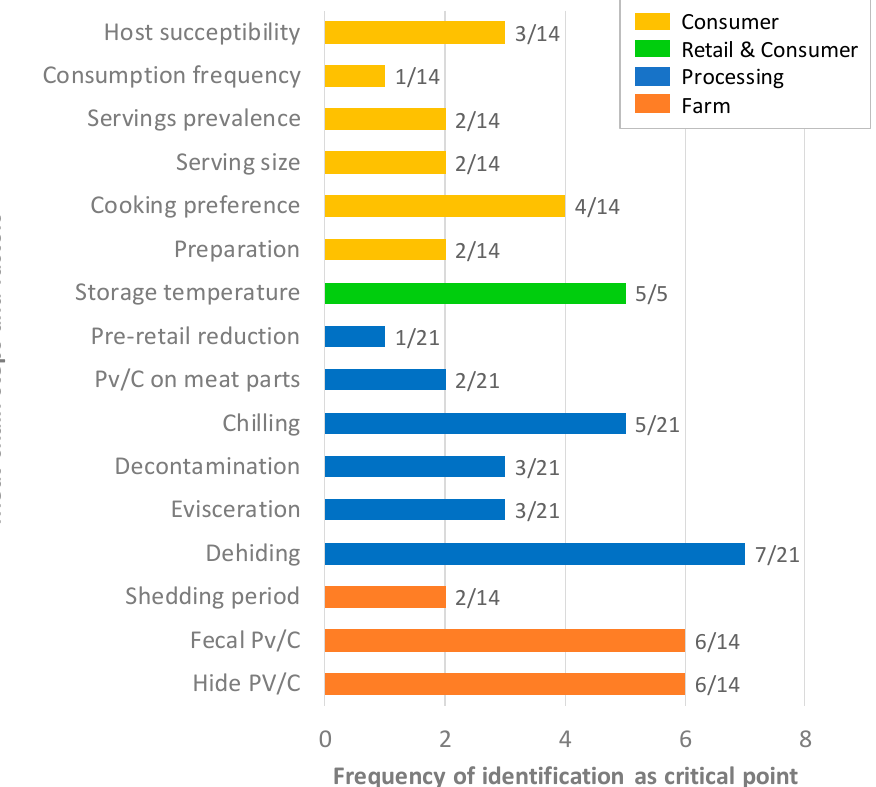
Figure 5. Frequency of identification of steps and factors as critical points for each meat chain stage (Pv/C: prevalence and/or counts). NB: steps or factors were counted only when they were identified within the first five priorities, e.g., dehiding 7/21 means that this step was considered in the sensitivity analysis of 21 QMRAs and identified seven times in the first five priorities.